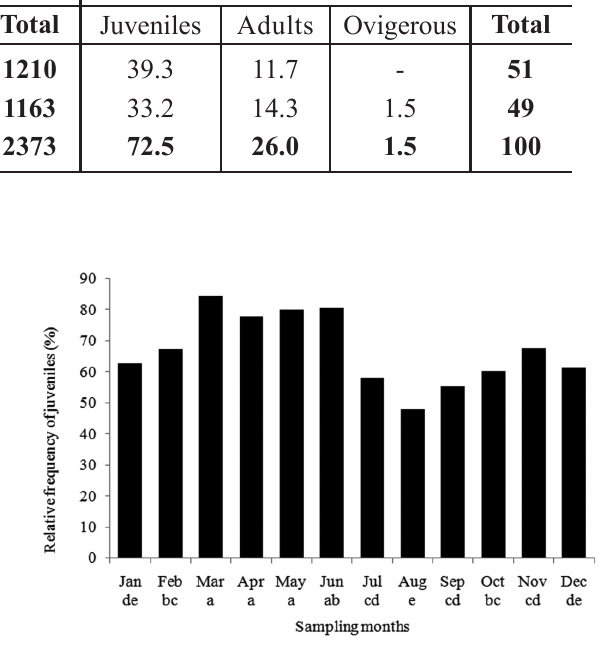
Fig. 2 – Callinectes danae . Relative abundance of adults and juveniles of both sexes, in the upper and lower estuaries at the Santa Cruz Channel. The total number obtained in these sites is also presented.